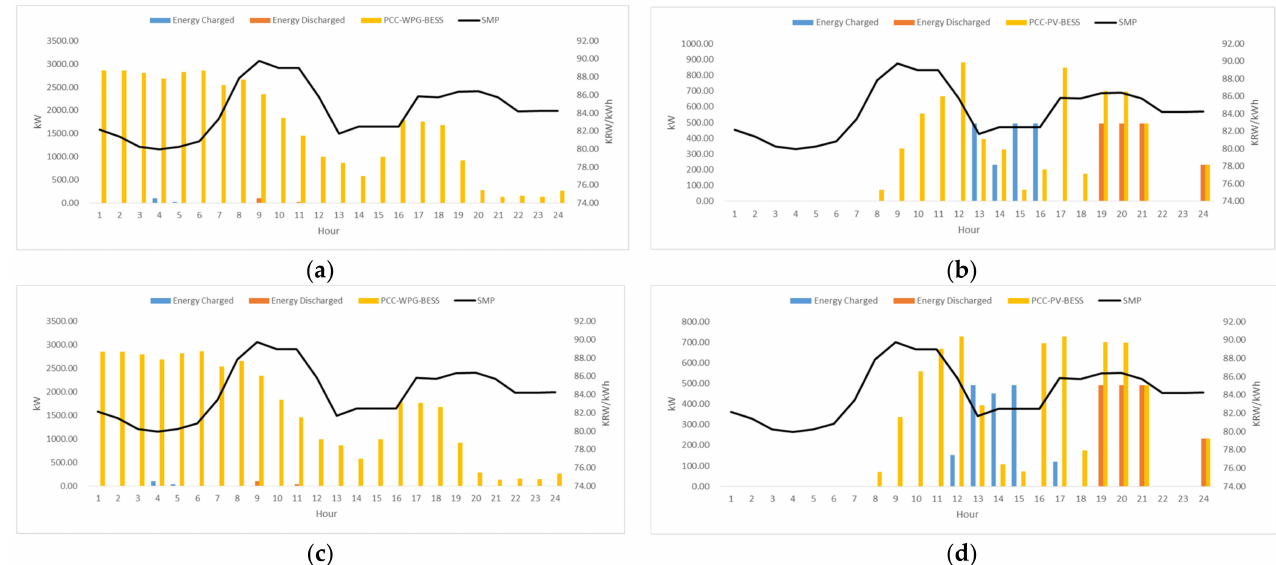
Figure 12. Operation of the BESS and the PV in coordinated with profit maximization, with reliability constraints, without the incentive: ( a ) intraday operation of the BESS with WPG with profit maximization; ( b ) intraday operation of the BESS with the PV with profit maximization; ( c ) intraday operation with the reliability constraint of the BESS with WPG; ( d ) intraday operation with profit maximization and the reliability constraint of the BESS with the